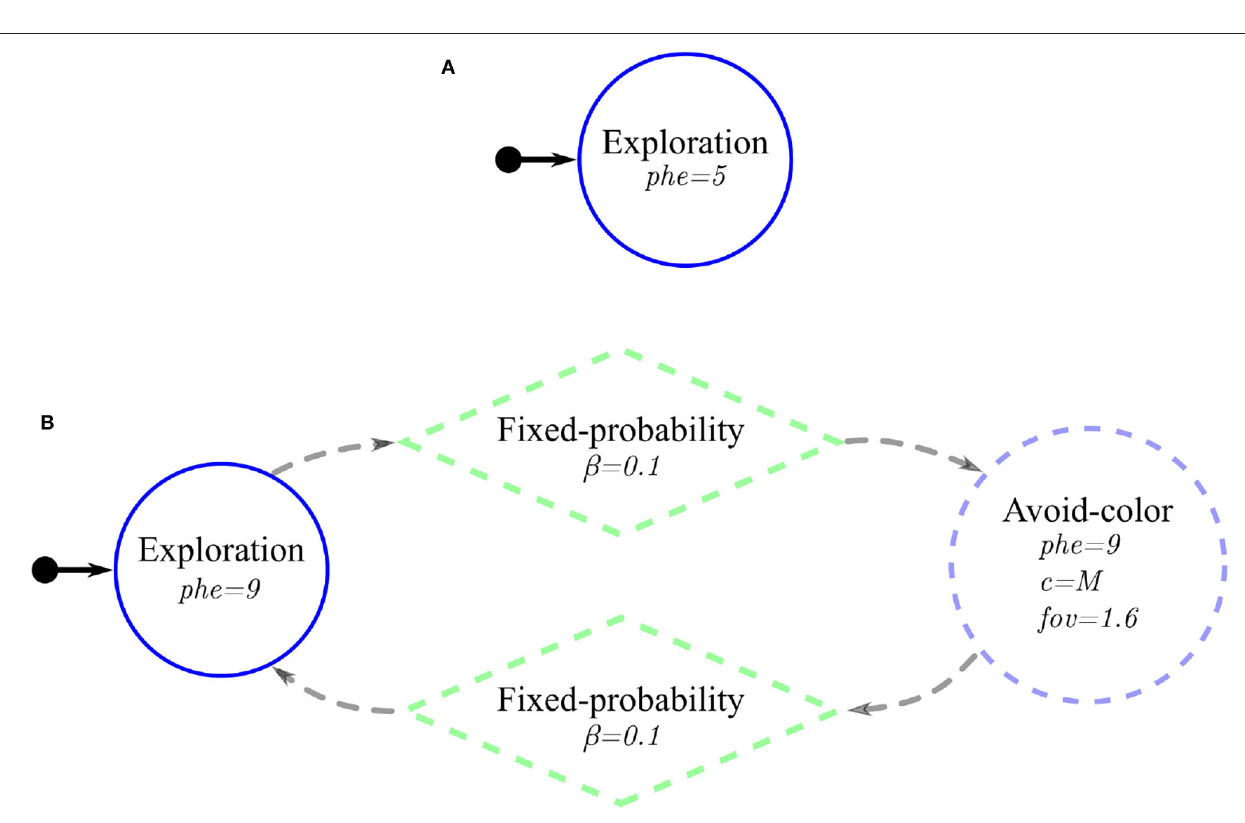
FIGURE 5 | Probabilistic finite-state machines for the two COVERAGE experiments: (A) Basic- COVERAGE and (B) Phormica - COVERAGE —the difference between the two probabilistic finite-state machines is highlighted with dashed-lines. In both finite–state machines, a circle, a lozenge, and an arrow with a small circle represent the states, transition, and initial state,